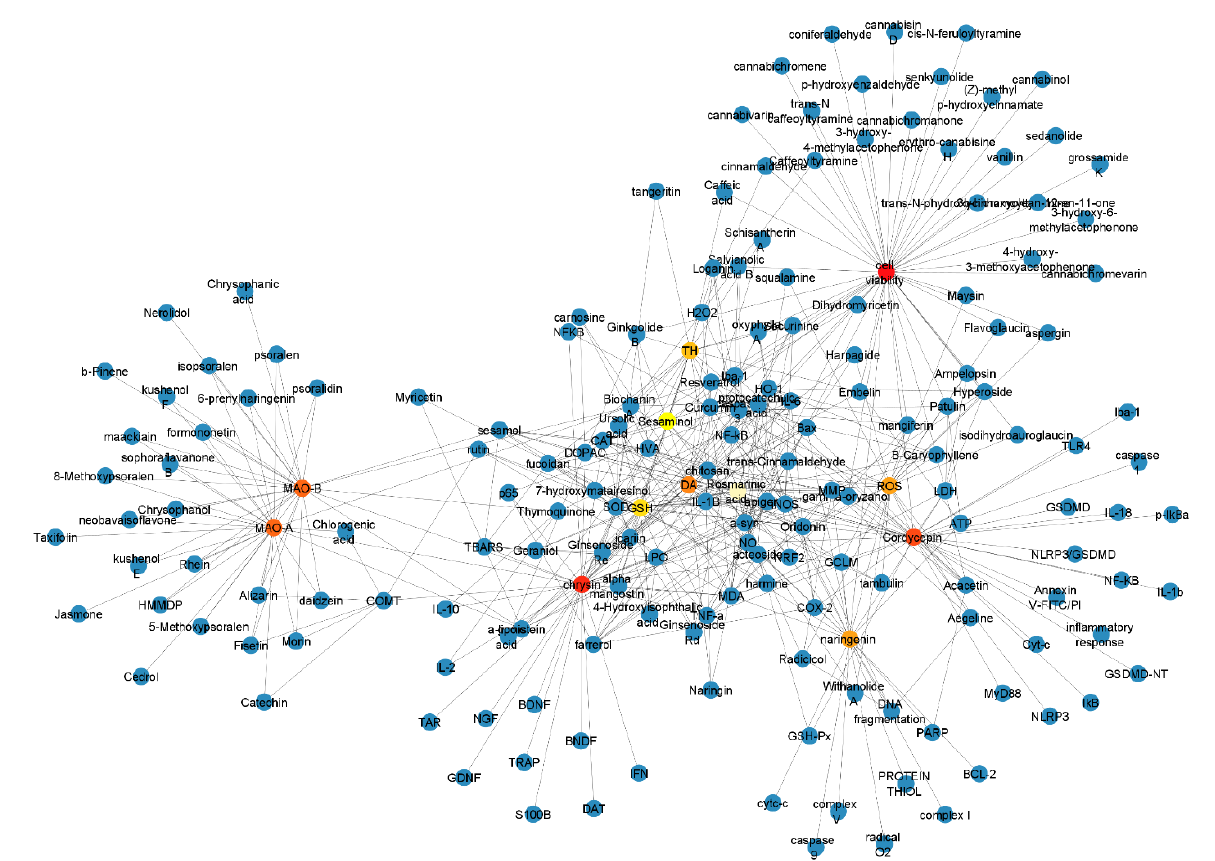
Figure 2. Structural network of the drugs used for the PD treatment and their pharmacological targets and their representative components. The upper structural network organizes the compounds (green nodes) and their pharmacological targets (yellow nodes). The structural network below derived from the Cytohubba plug-in shows the most connected nodes (rosmarinic acid, chrysin, naringenin, and cordycepin, and MAO-A and MAO-B). Nodes represent the compounds and pharmacological targets, and edges are the reported interactions between